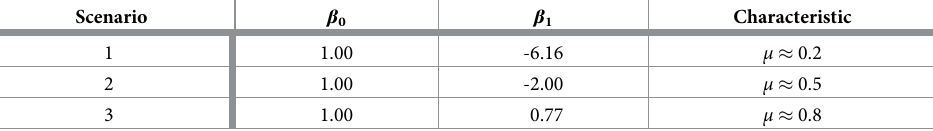
Table 1. Parameter values for scenarios considered in the simulation, when the true data-generating process is UL distributed (in-control condition).